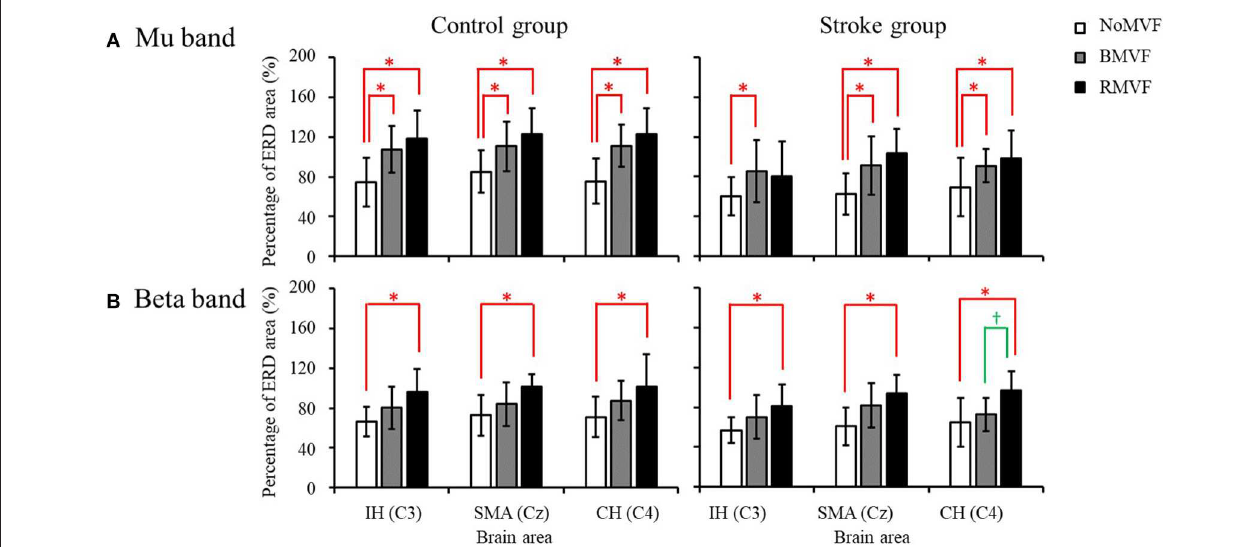
FIGURE 5 | Overall event-related desynchronization (ERD) areas of the control and stroke group ( n = 16 each) with error bars (standard deviations) for the three test conditions (NoMVF: white; BMVF: gray, and RMVF: black) for the IH (C3), SMA (Cz), and CH (C4) brain areas, respectively. (A) Overall ERD areas (%) of the mu band (B) Overall ERD areas (%) of the beta band. * , † Overall ERD areas (%) of this test condition are significantly higher than the previous one for the same brain